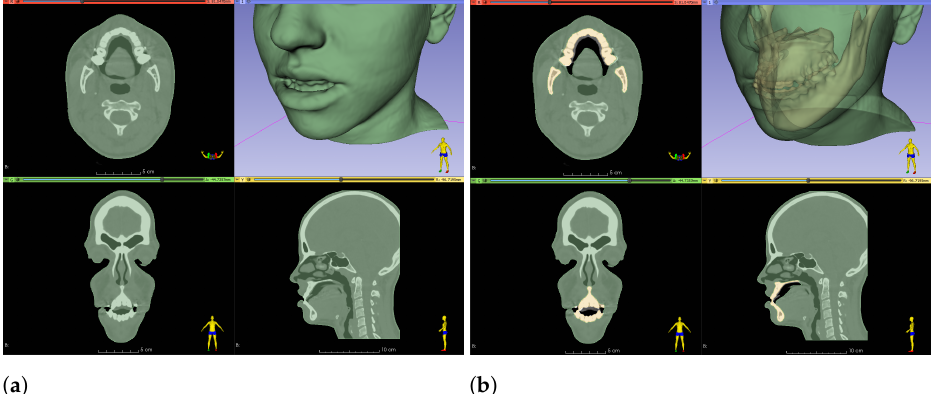
Figure 4. Results of segmentation in 3D Slicer. ( a ) shows segmentation of the entire patient. ( b ) shows segmentation of skin and bones.